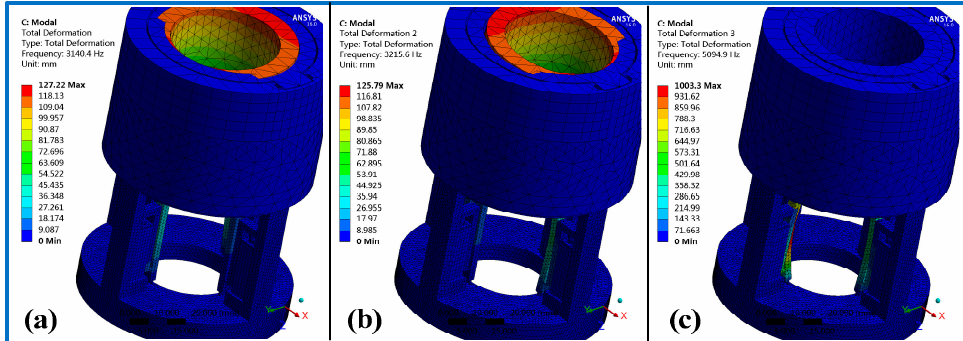
Figure 21. Modal analysis results of the piezoelectric focusing mechanism. ( a ) First-order mode; ( b ) second-order mode; ( c ) third-order mode.